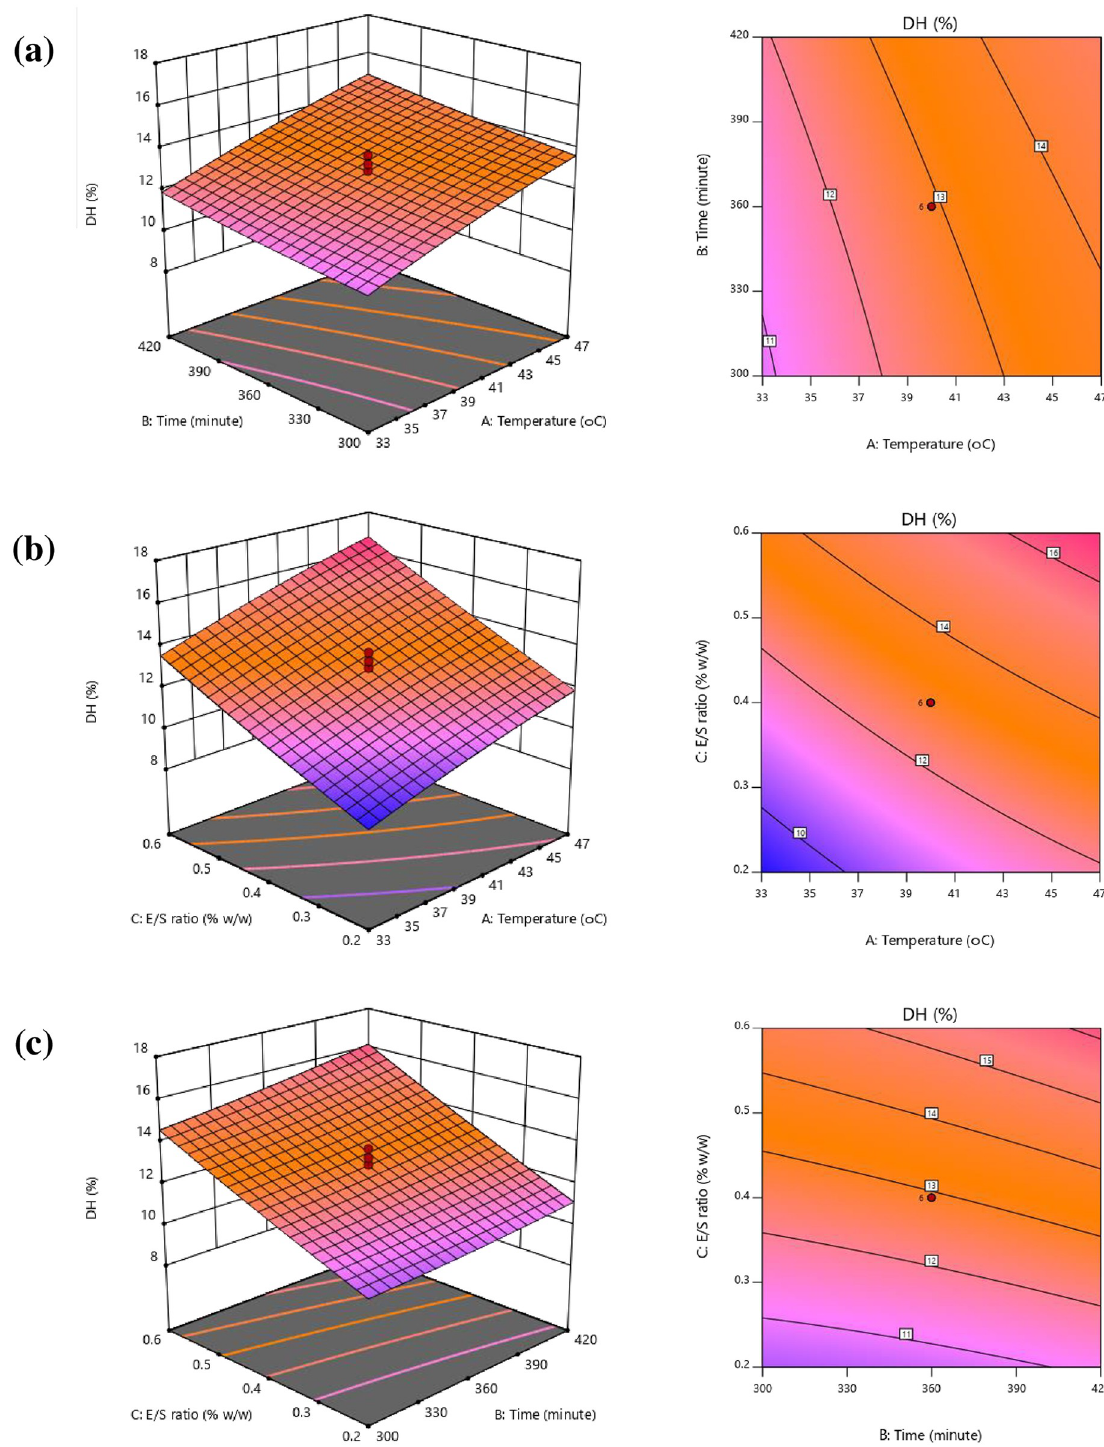
Fig 2. Response surface and contour plots presenting the influence of interactions among independent variables upon the degree of hydrolysis (%DH). (a) influence of temperature and time, (b) influence of temperature and E/S ratio, and (c) influence of time and E/S